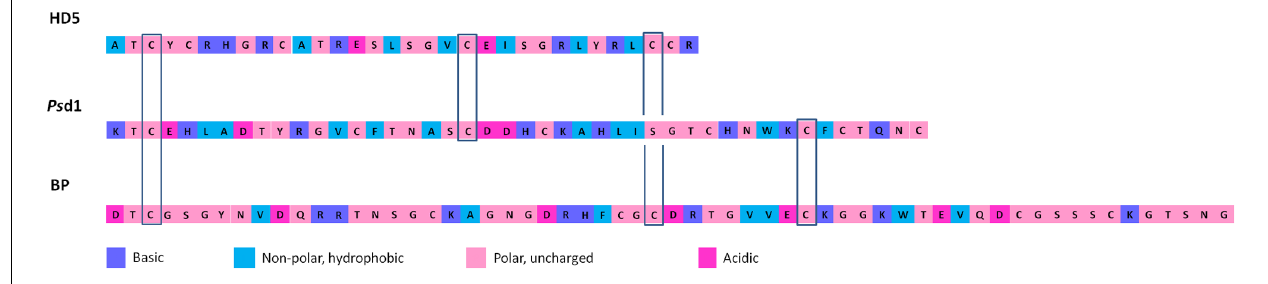
FIGURE 1 | Comparison of amino acid residues sequence of selected defensins with antifungal activity from animals, plants, and fungi: human defensin 5 (HD5), Pisum sativum defensin 1 (Psd1), and Penicillium brevicompactum Dierckx bubble protein (BP),